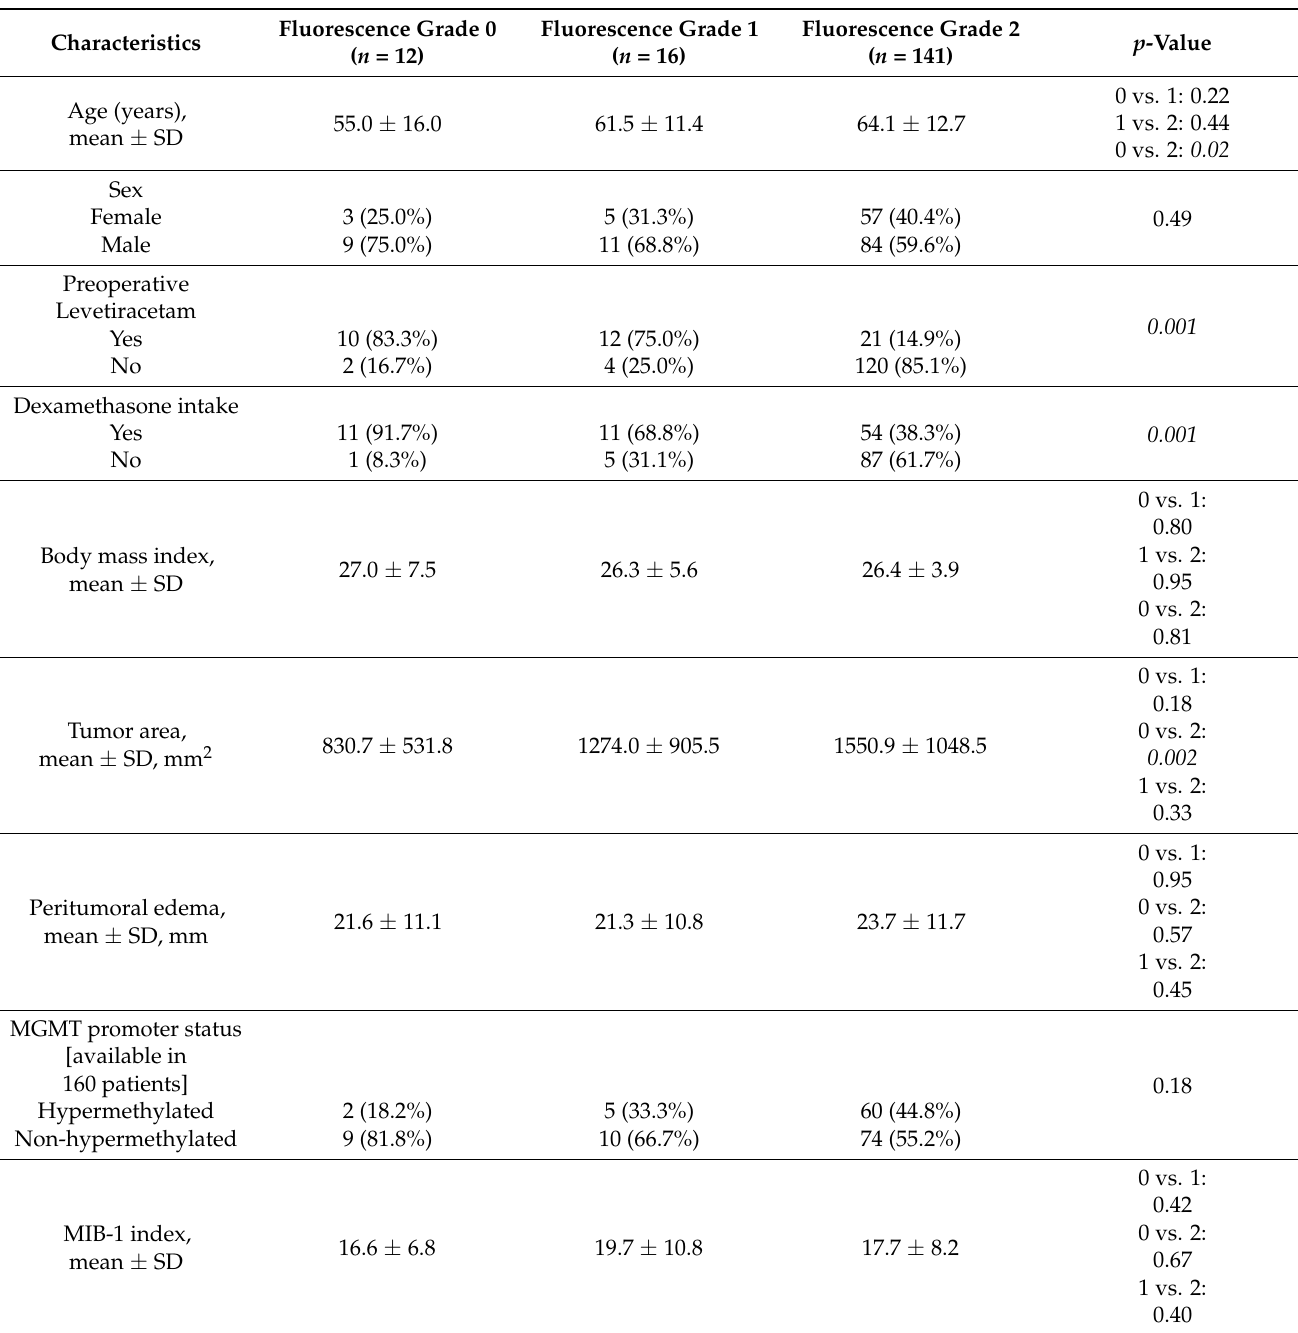
Table 3. Comparison of patient characteristics among fluorescence quality grades in patients treated with levetiracetam or without AEDs (using Fisher’s exact test (two-sided) and independent t -test) ( n =